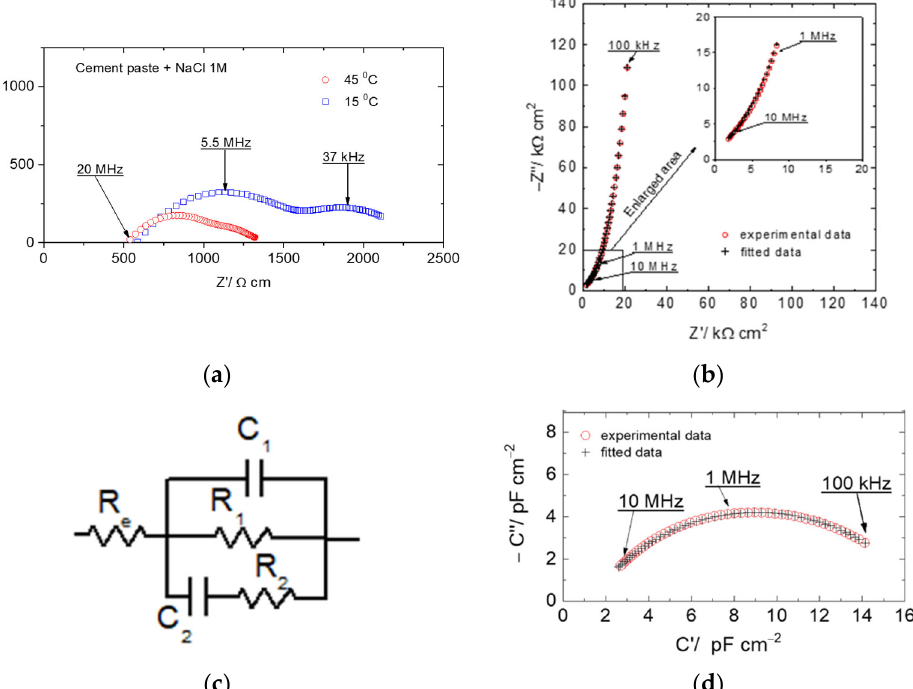
Figure 2. Typical impedance plots for cement paste samples using ( a ) a permeation cell [30] and ( b ) a parallel plate with insulated surfaces [29]. ( c ) Equivalent electrical circuit (see text for details). ( d ) Transformation of data in ( b ) using Equation (1).